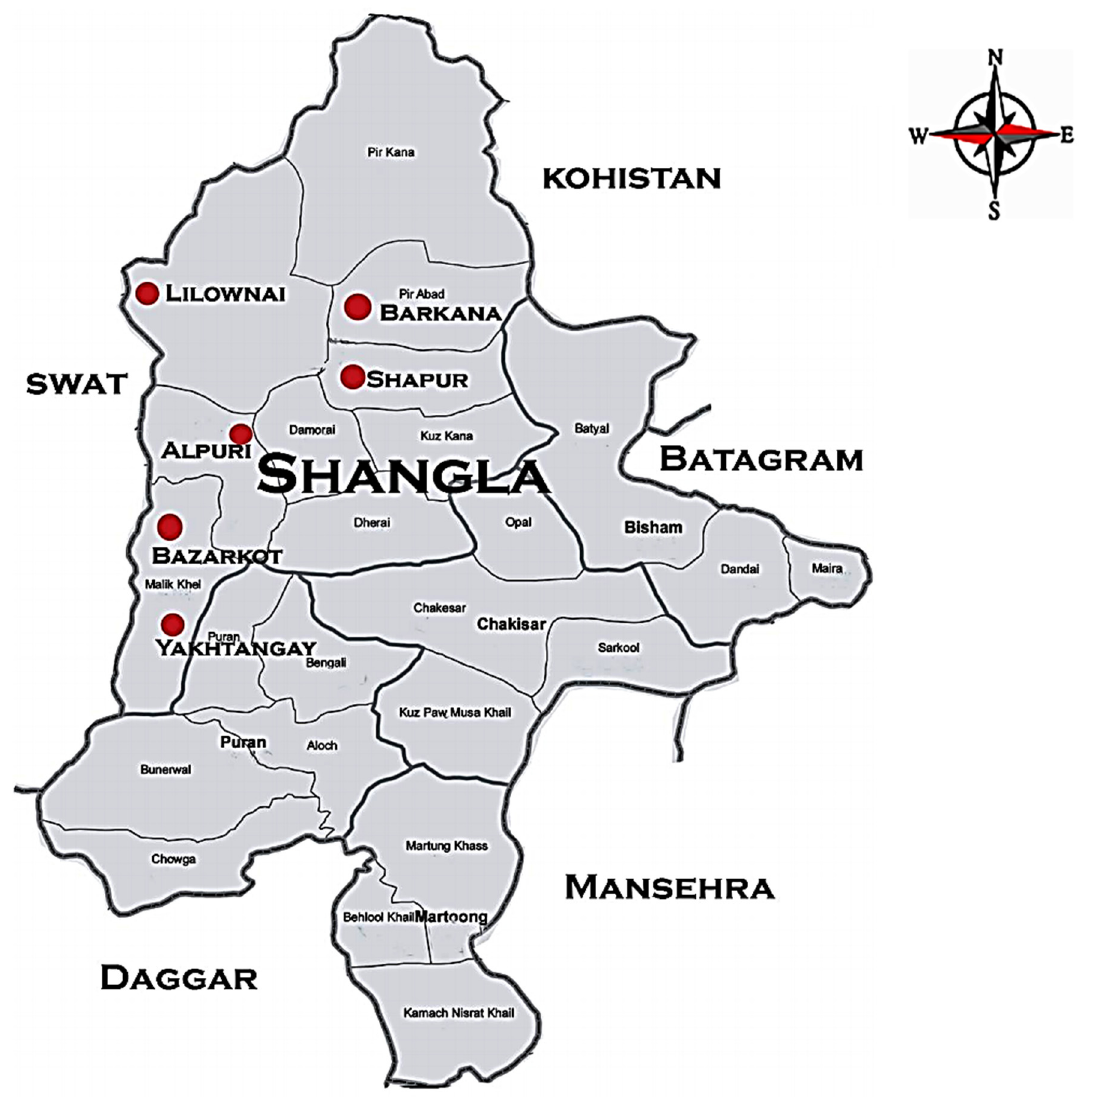
Figure 1. Geographical location of the District Shangla (study area), Khyber Pakhtunkhwa, Pakistan (adopted from Tabani, et al., 2016).